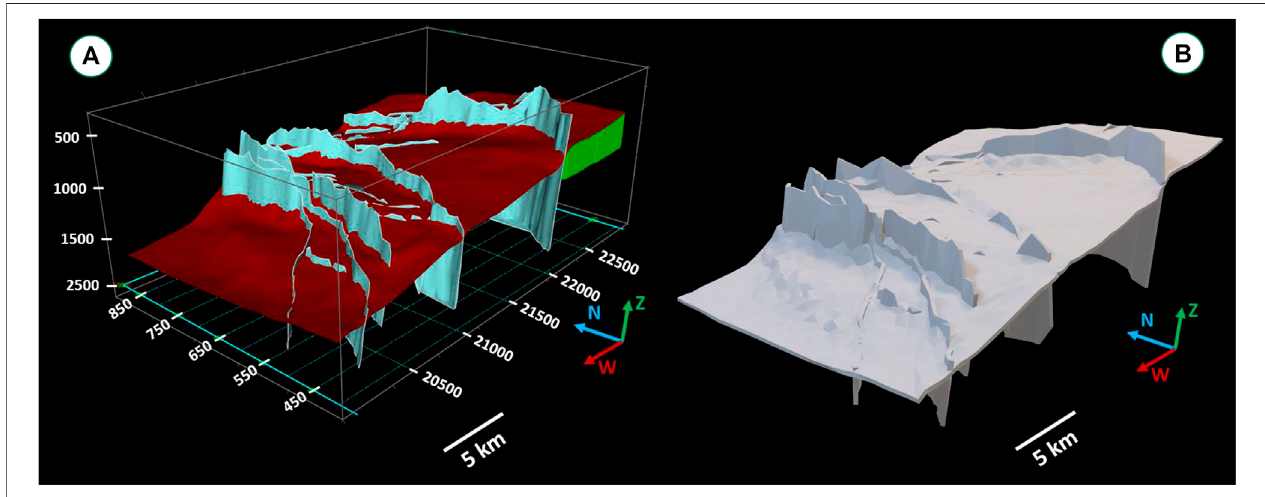
FIGURE 2 | (A) 3D geological structure model from 3D Move software. (B) Final 3D geological structure model from SketchUp software.